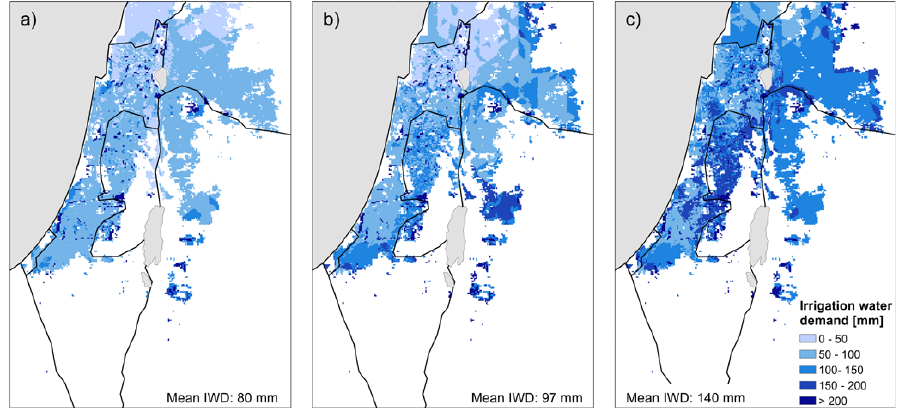
Fig. 8. Simulated annual irrigation water demand (IWD) in millimeters. The figure shows (a) the current reference conditions based on the period 1961–1990, (b) the annual IWD based on the HadCM3-MM5 climate model control run and a drought year in 1961–1990, and (c) the annual IWD based on the HadCM3-MM5 climate model and a drought year in 2031–2060. The figure shows agricultural land only, and an assumption of no land use change has been